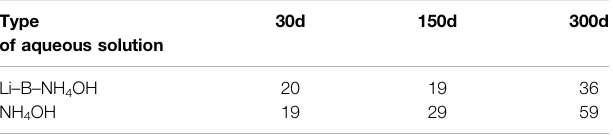
TABLE 5 | Hydrogen absorption in the specimens in the two solutions after 30, 150, and 300 days of the